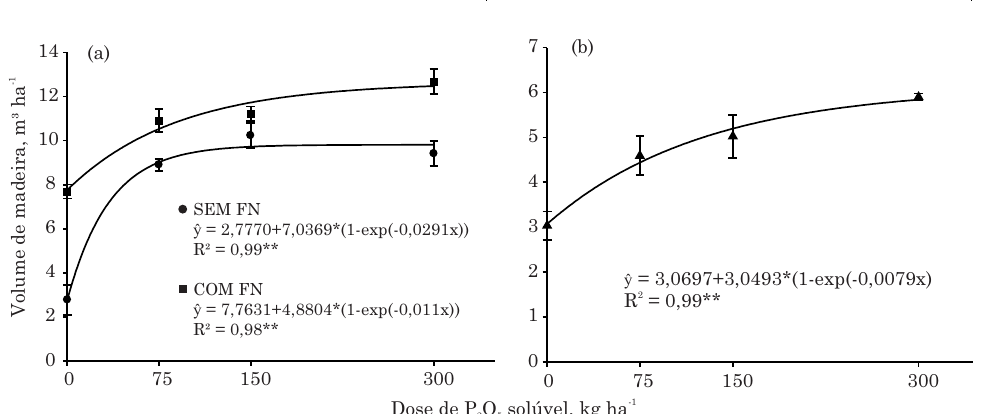
Figura 2. Volume de madeira com casca de Eucalyptus benthamii (a) e de Eucalyptus dunnii (b) , submetido às fontes e doses de P. ** significativo a 1 % pelo teste F.